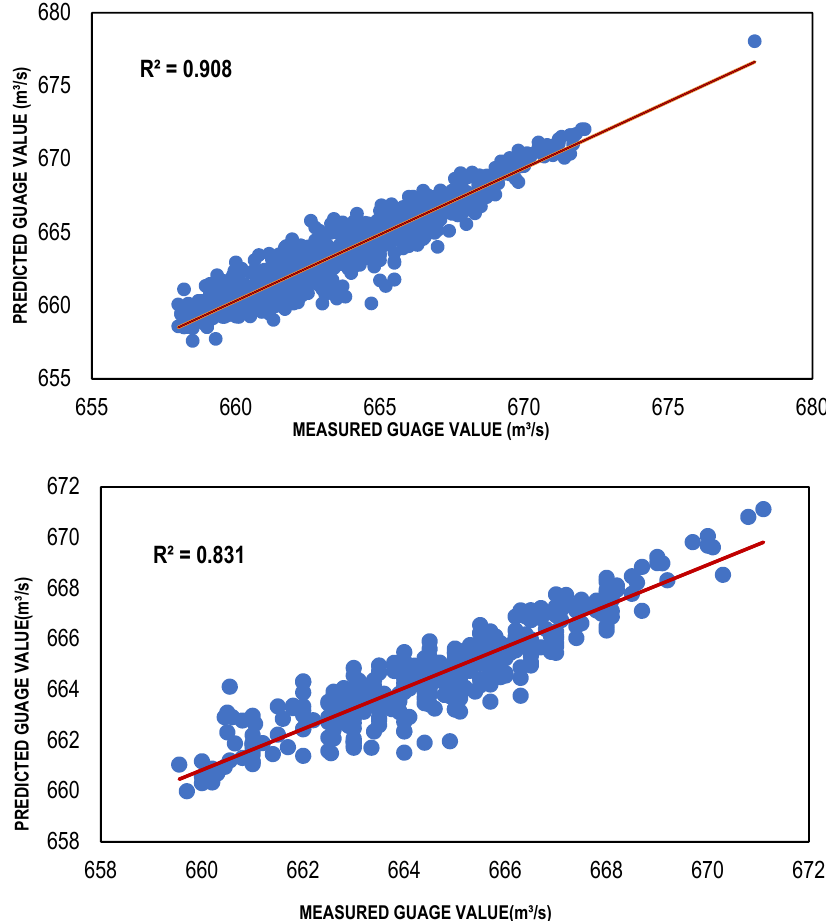
Figure 4. Best LLR-based models (training and testing).